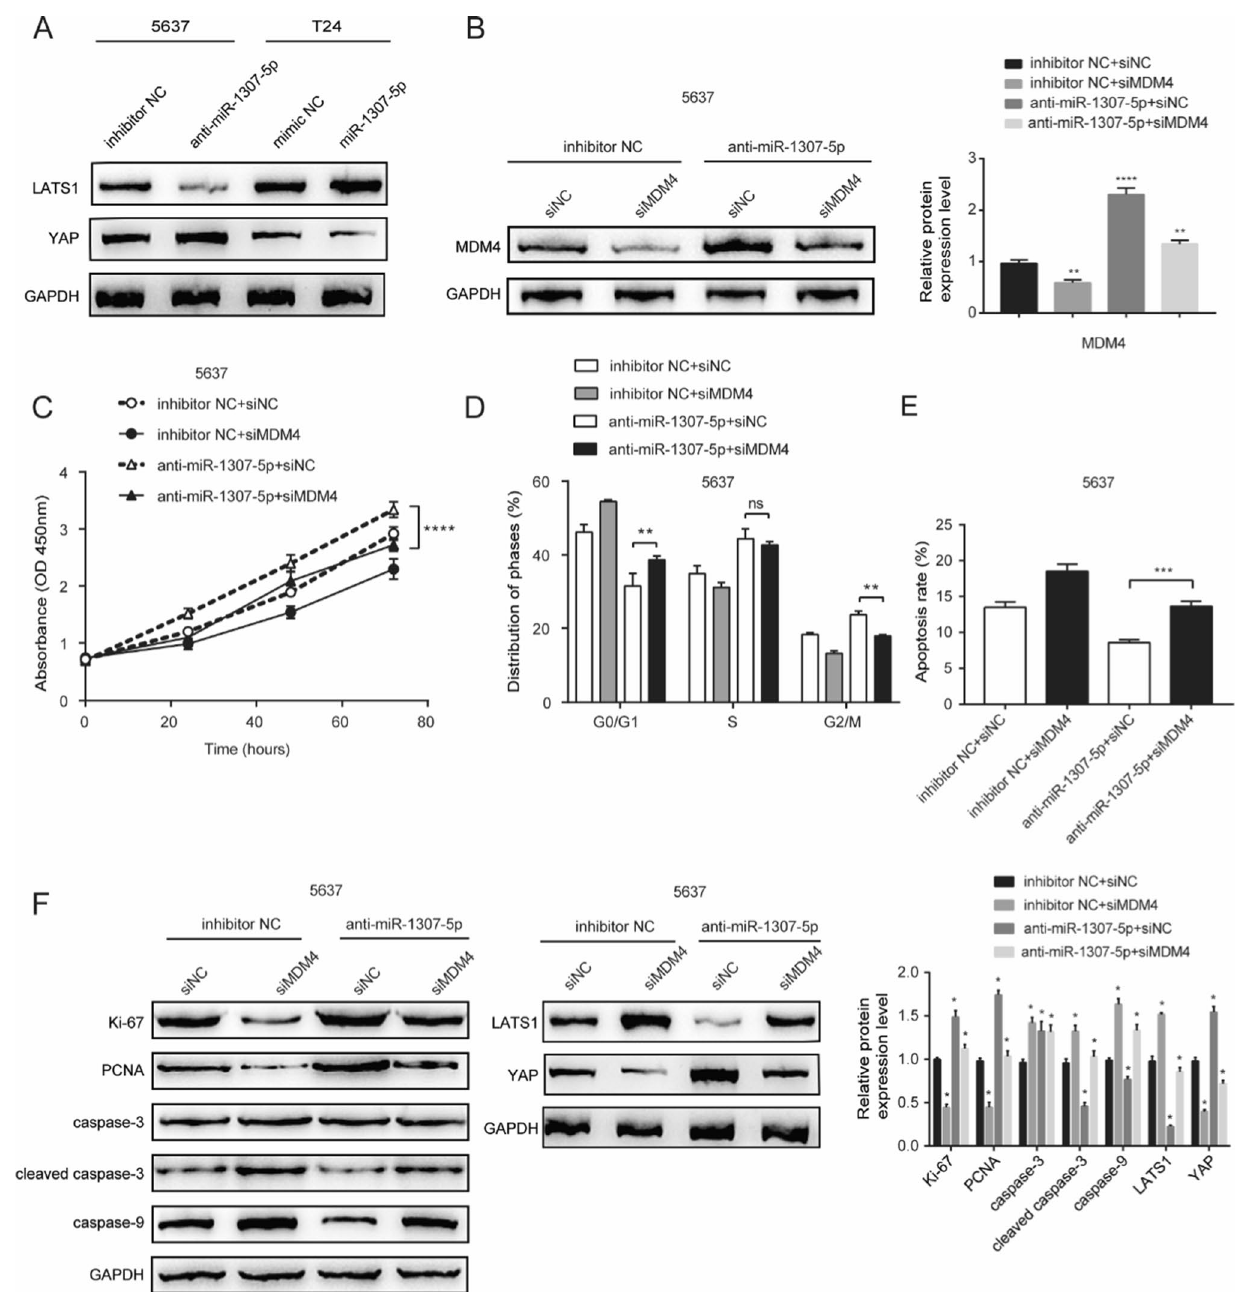
Fig. 5 miR-1307-5p effects were mediated by—MDM4 and the Hippo pathway. A Western blotting of LATS1 and YAP in 5637 and T24 cells. B Western blotting of MDM4 protein in 5637-anti-miR-1307-5p cells—transfected with siMDM4. C Proliferation of 5637-anti-miR-1307-5p cells transfected with siMDM4 as determined by CCK-8 assay. D Cell cycle of 5637-anti-miR-1307-5p cells transfected with siMDM4 as deter- mined by flow cytometry assay with PI staining. E Flow cytometry assay with Annexin V and PI staining—to determine the effects of MDM4 on the cell apoptosis of bladder cancer cells. F MDM4 knockdown decreased the expression of Ki-67, PCNA, YAP and increased the levels of cleaved caspase3, caspase9, LATS1 in 5637-anti-miR-1307-5p cells. **p < 0.01; ***p < 0.001; ****p < 0.0001; ns, no significance. Data depicts the mean ± standard deviation and are representative of three independent